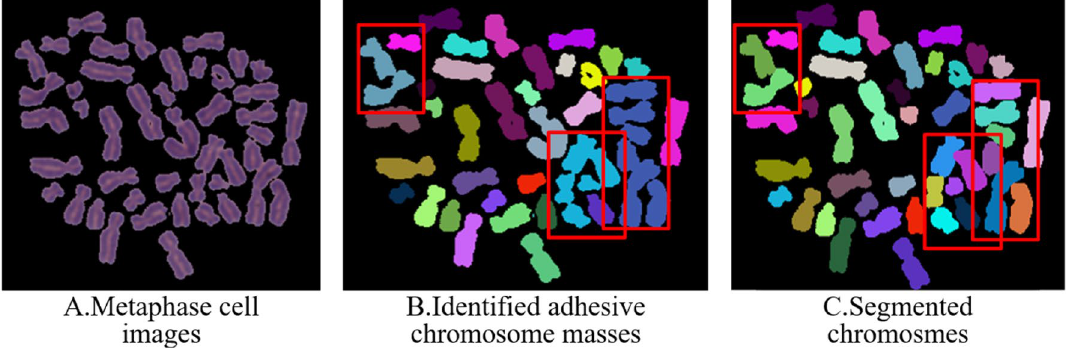
Figure 6. Process of automatic segmentation of adhesive chromosome